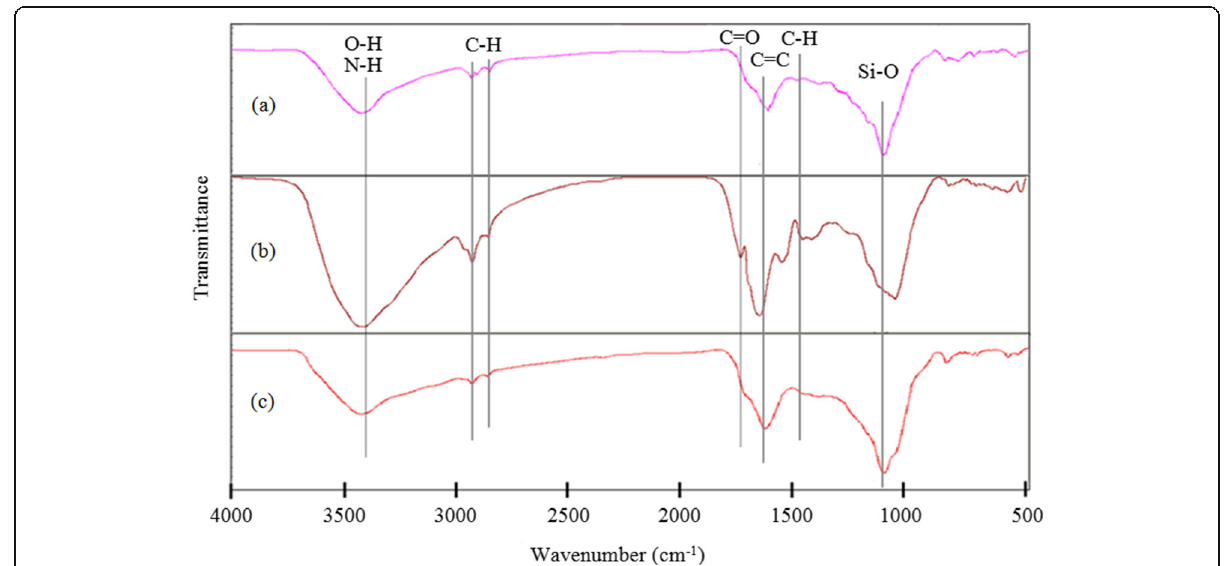
Fig. 5 FTIR spectrums of a PB, b 1Fe2MnC and c 1FeC